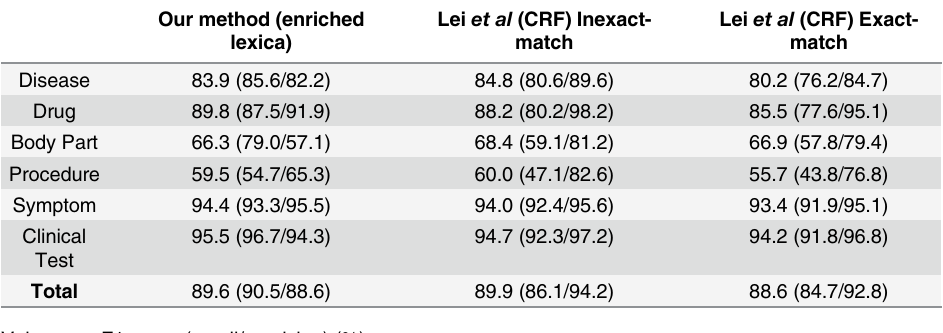
Table 4. Comparison of two methods in term recognition: recall, precision and F1-score.